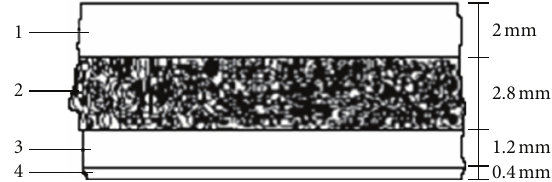
Figure 3: Sketch of layered sphere. The thin-walled structure of cranial cavity is mainly composed of Tabula externa, Diploe, Tabula interna, and dura